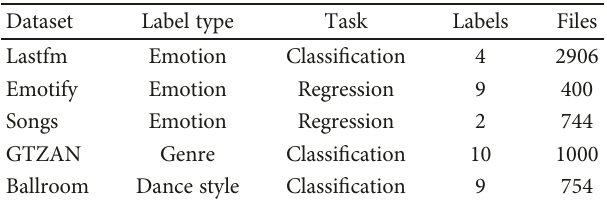
Table 1: Summary of the